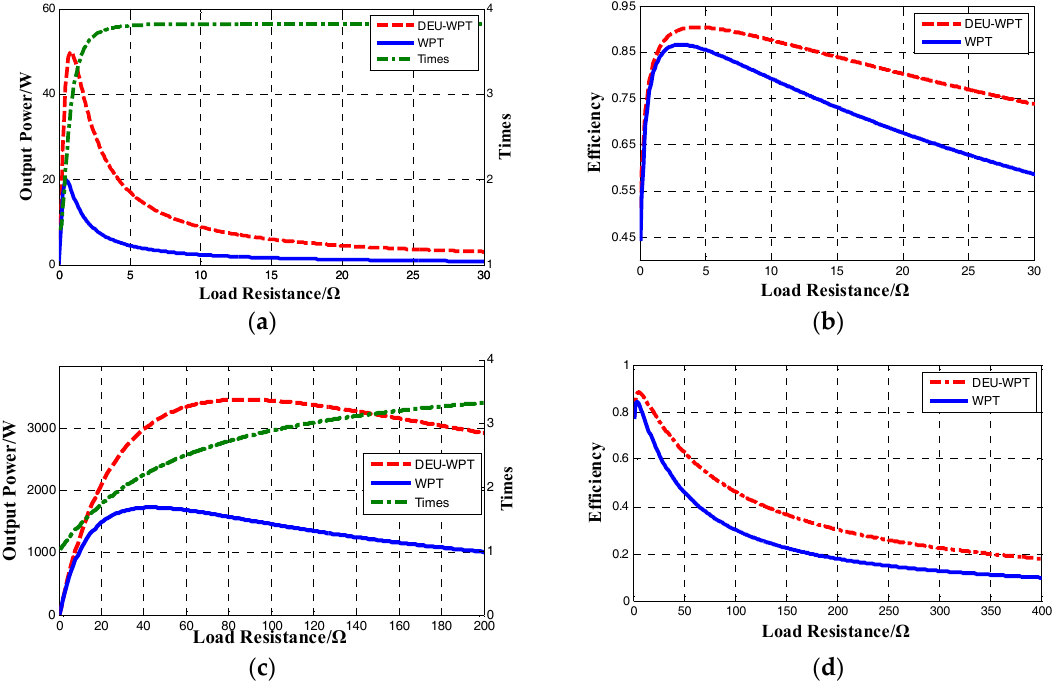
Figure 6. Output characteristics under system load variation: ( a ) The output power of PS-type (Primary Parallel Secondary Series) system under load changes; ( b ) The efficiency of PS-type system under load changes; ( c ) The output power of SS-type (Primary Series Secondary Series) system under load changes; ( d ) The efficiency of SS-type system under load changes.